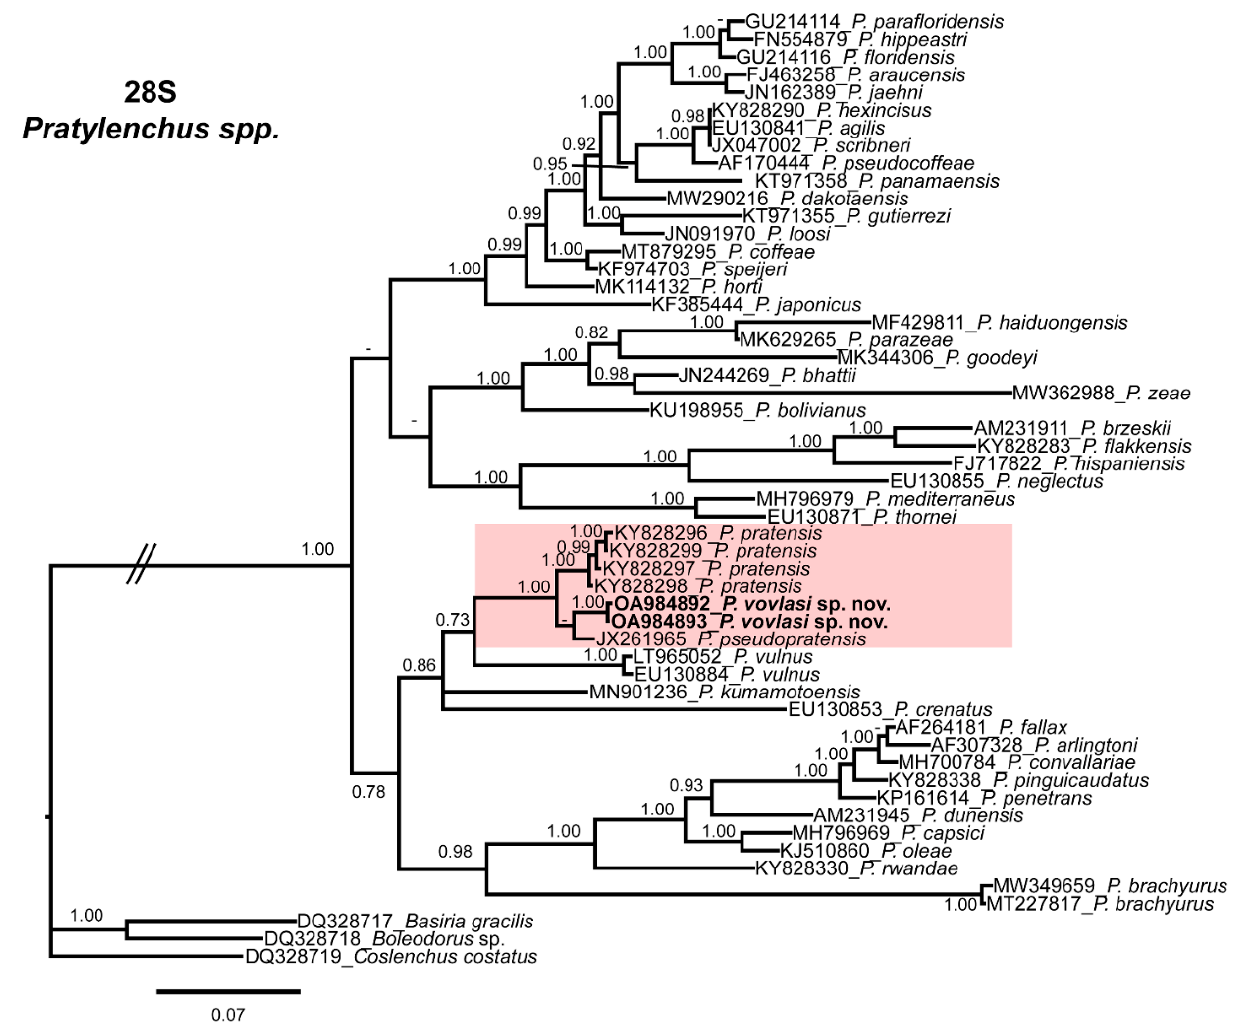
Figure 2. Phylogenetic relationships of Pratylenchus vovlasi sp. nov. within the genus Pratylenchus . A Bayesian 50% majority-rule consensus tree as inferred from the D2 and D3 expansion domains of the 28S rRNA sequence alignment under the general time-reversible model of the sequence evolution with a correction for invariable sites and a gamma-shaped distribution (GTR + I + G). Posterior probabilities more than 0.70 are given for appropriate clades. Newly obtained sequences in this study are shown in bold. Scale bar = expected changes per site.